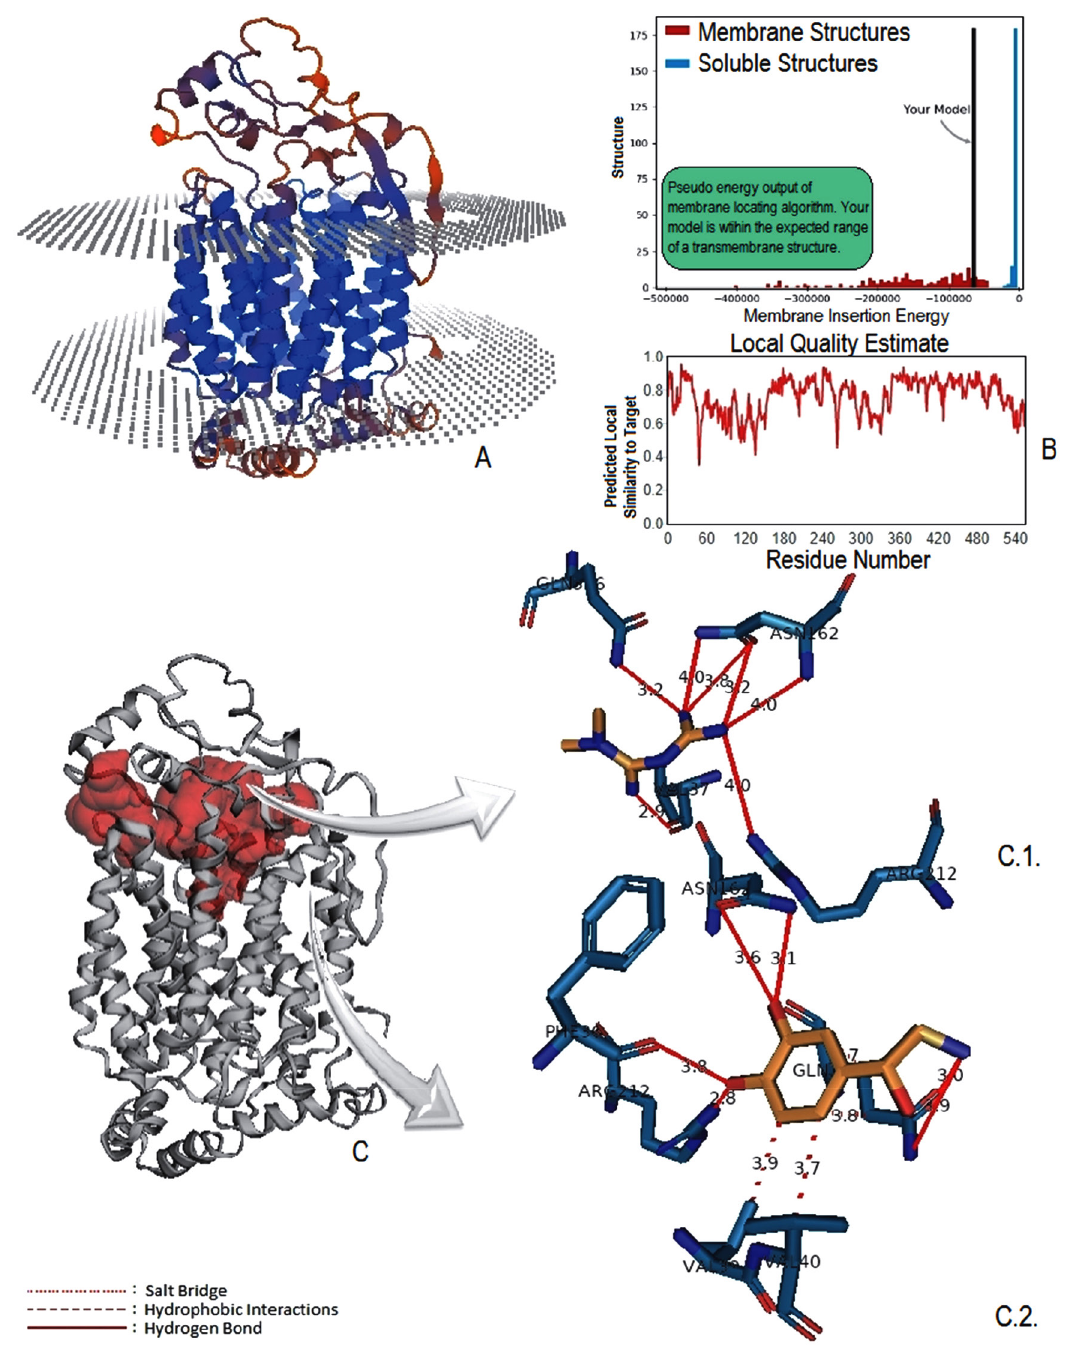
Figure 5. Representation of the molecular modeling of OCT-3 and metformin, and norepinephrine. A. OCT-3 transmembrane protein embedded in the plasma membrane model was predicted by QMEANBrane. B. Structure validation of modeled OCT-1 concerning membrane insertion energy and the local quality estimate of the residues of the model OCT-3. C. The surface of the binding pocket of the model OCT-3 is computed using CASTp 3.0. Molecular simulation of the best pose of the interaction of OCT-3 and metformin(C1), norepinephrine (C2) with the highest docking